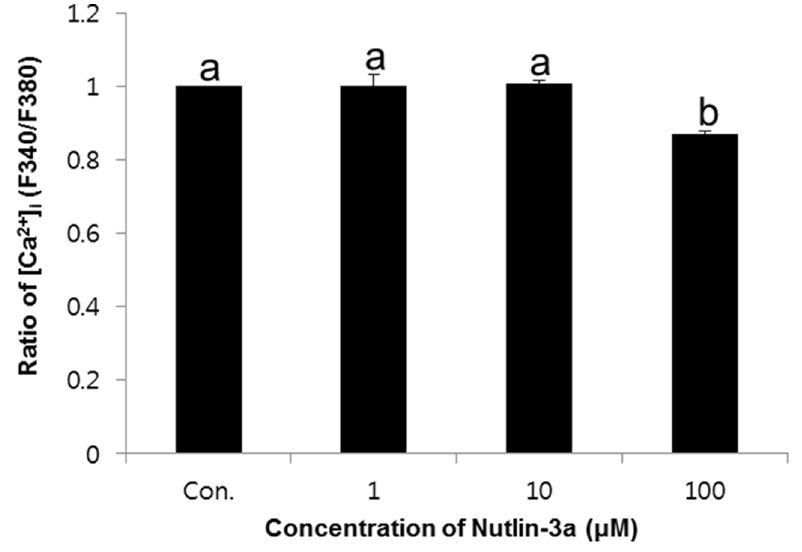
Figure 2. Effects of nutlin-3a on change of [Ca 2+ ] in spermatozoa. Data are expressed as the mean ± SEM, n=3. Values with i different superscripts ( a,b ) indicate significant differences between control and treatment groups on one-way ANOVA ( p <0.05).